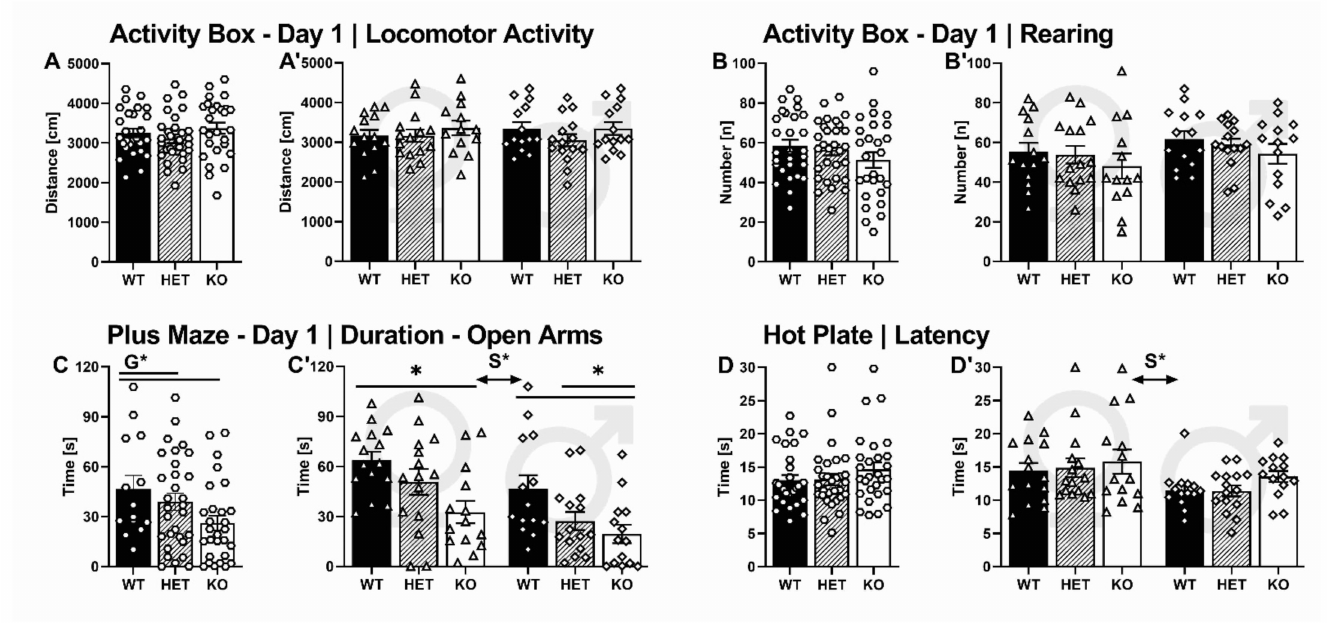
Figure 7. Additional behavioral assays. Effects of SERT deficiency on novelty-seeking in the activity box ( A – B’ ), anxiety-like behavior in the elevated plus maze ( C , C’ ), and pain sensitivity in the hot plate test ( D , D’ ). Depicted are measures for SERT +/+ (black bar), SERT +/ − (striped bar), and SERT − / − (white bar) rats with sexes pooled ( A – D ) and separated by sex ( A’,B’ , C’,D’ ), with females on the left and males on the right side of the panel. Measures are ( A ) distance travelled in the activity box; ( B ) number of rearings in the activity box; ( C ) time spent in open arms of the elevated plus maze; and ( D ) latency to withdraw a paw in the hot plate test. N = 44 female (15 +/+, 15 +/ − , 14 − / − ), N = 43 male (14 +/+, 15 +/ − , 14 − / − ) rats, except activity box (see materials and methods for details). Data are presented as mean ± SEM. G* p < 0.05 effect of genotype, with lines indicating significant post-hoc comparison between genotypes. S* p < 0.05 effect of sex. * p < 0.05 for subgroup